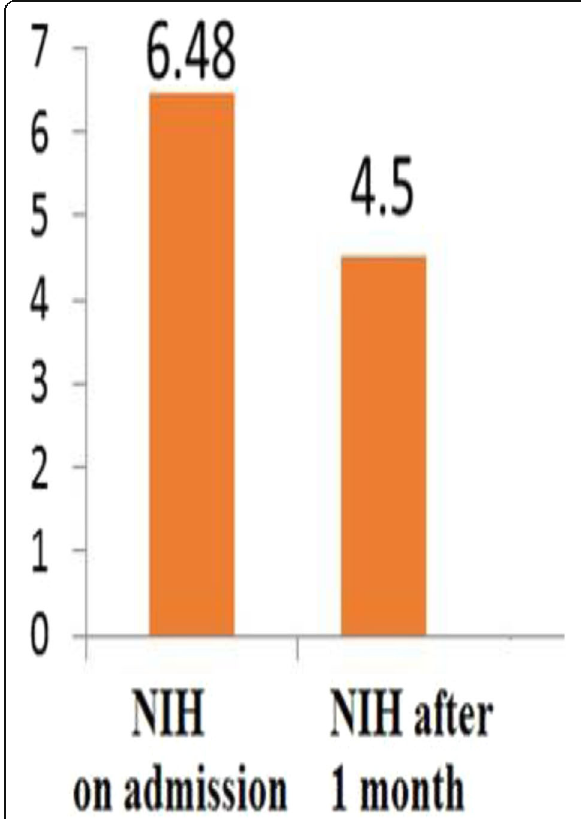
Fig. 1 Mean value of NIH on admission, after 1 month and MRS after 3 months. Patients were assessed using NIH stroke scale on admission, after 1 month and by modified Rankin scale after 3 months, mean value of NIH stroke scale on admission was 6.48 ± 2.97 ranging from 1 – 16, mean value of NIH stroke scale after one month was 4.5 ± 2.48 ranging from 0 to 9